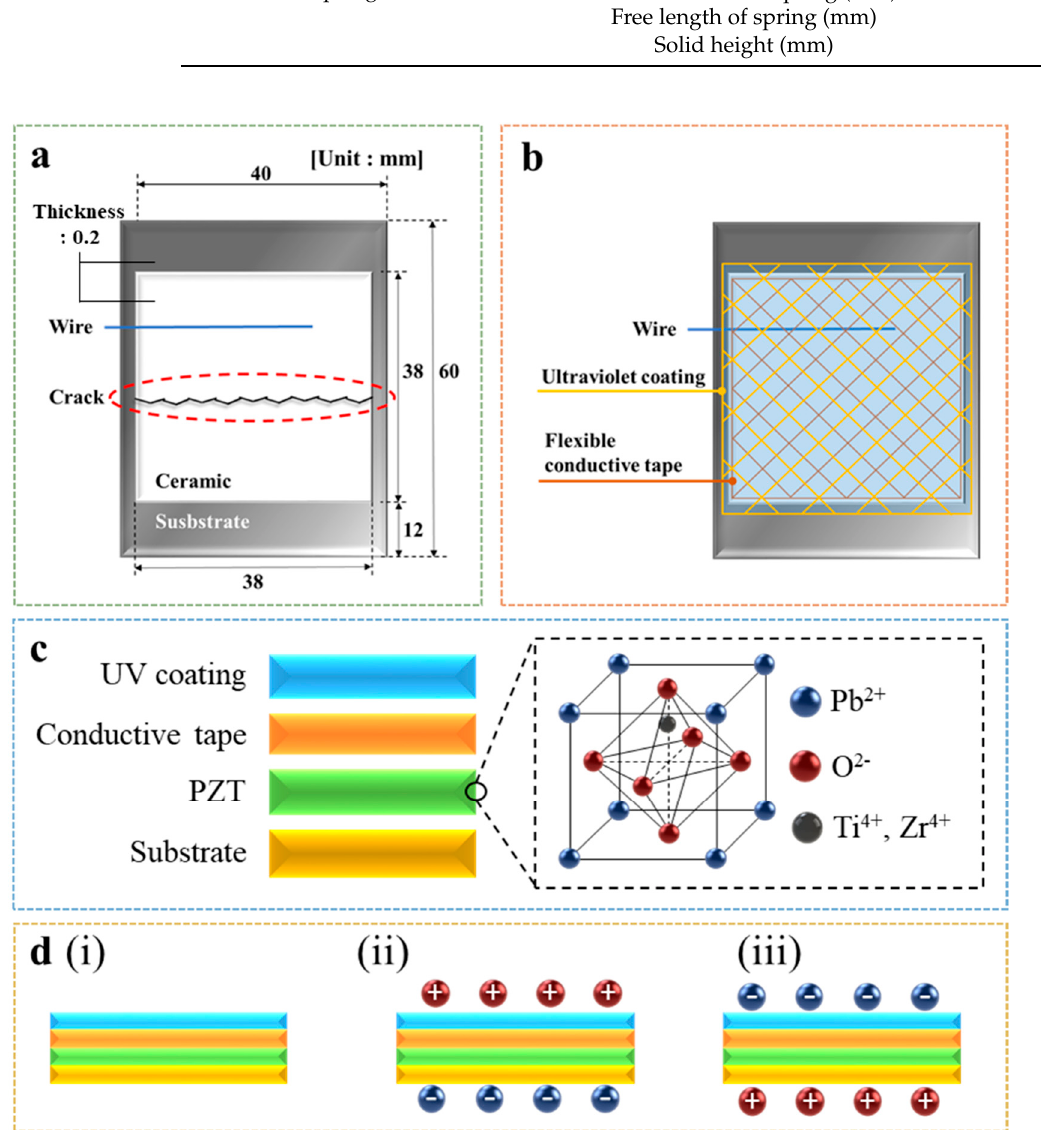
Figure 2. ( a ) Piezoelectric device with a crack, ( b ) Piezoelectric device with conductive tape and ultraviolet coating, ( c ) Layers constituting a piezoelectric device and a perovskite PZT unit cell, ( d ) Direction (polarity) of the voltage formed by default state ( i ), compression ( ii ) and release ( iii ). Table 1. Material and component properties.